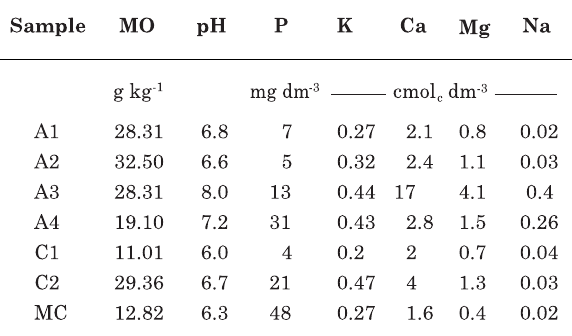
Table 2. Chemical characteristics of soil